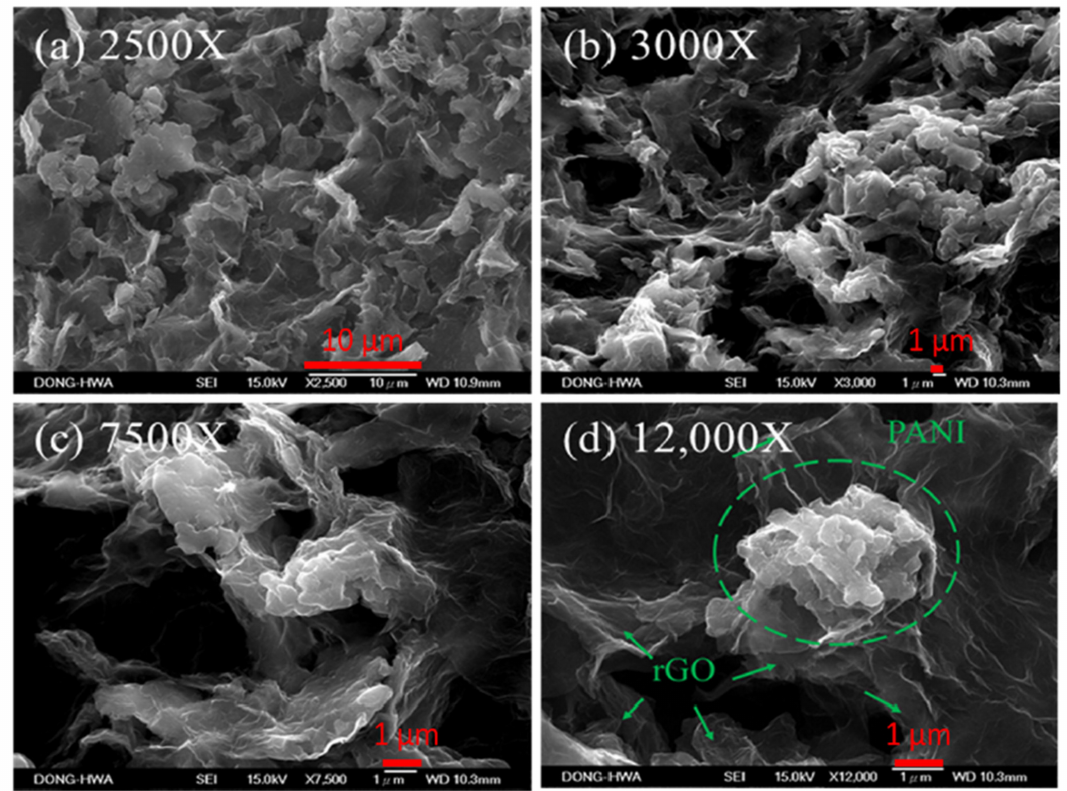
Figure 6. SEM images ( a ) 2500 × , ( b ) 3000 × , ( c ) 7500 × and ( d ) 12,000 × of 100 ◦ C-annealed rGO / PANI nanocomposites on graphite sheets.